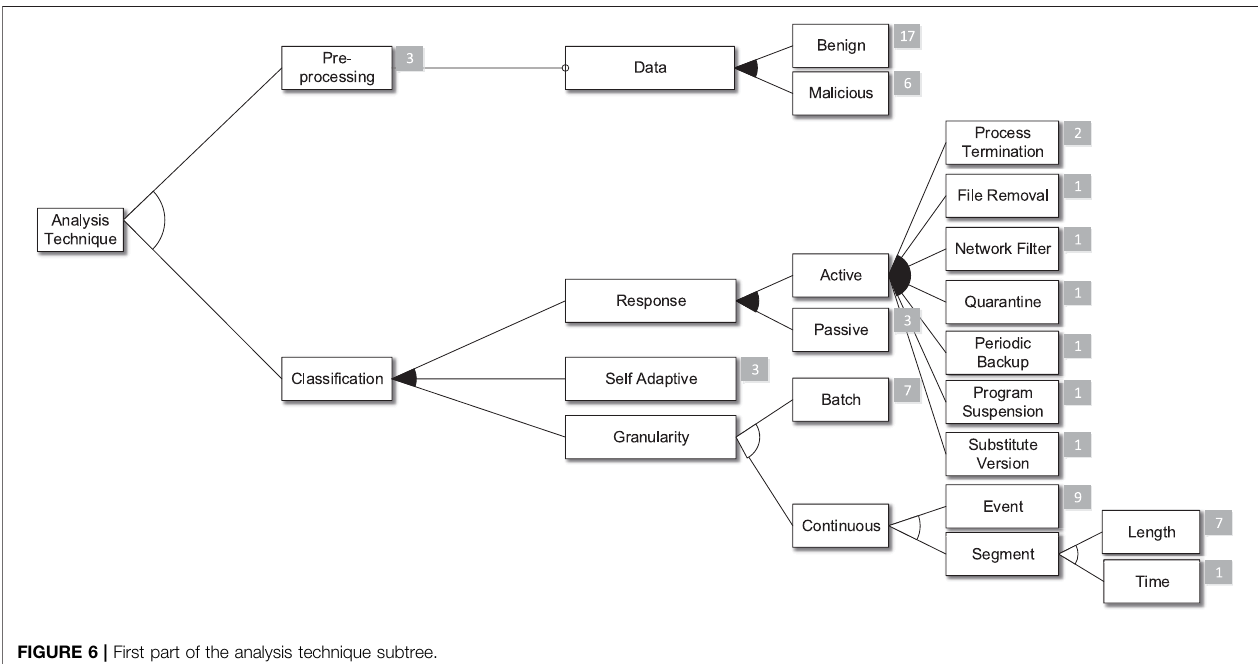
FIGURE 6 | First part of the analysis technique